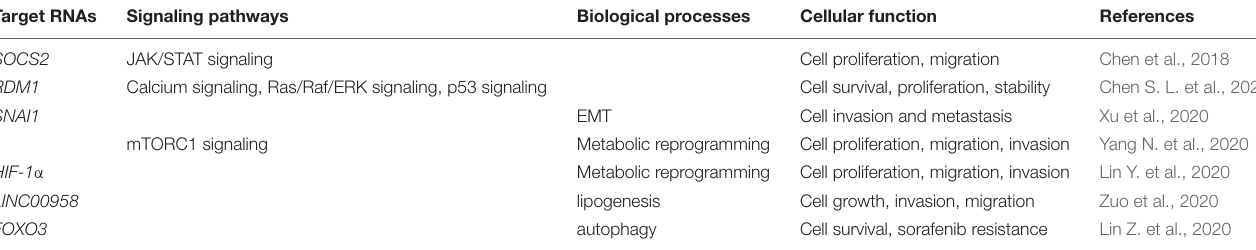
TABLE 1 | Roles of METTL3 in HCC.